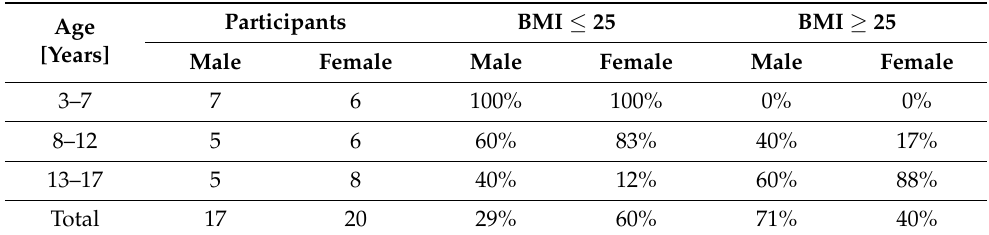
Table 1. Summary of information about the origins of the bacterial